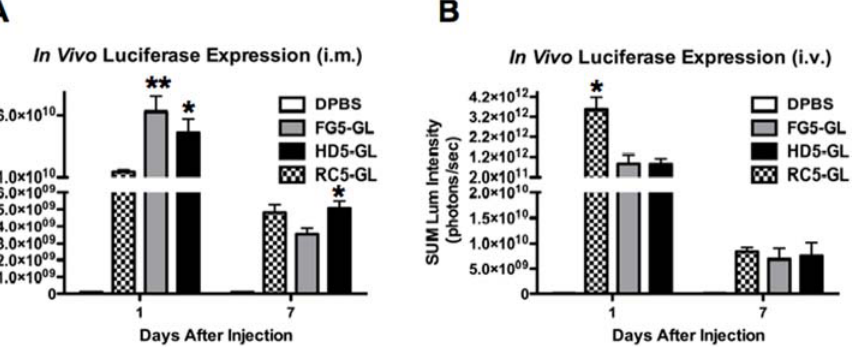
Figure 2. Luciferase imaging. In vivo transduction and expression produced by RC-Ad, FG-Ad, and HD-Ad expressing GFPLuc after i.v. (A) and i.m. (B) immunization. Groups of 5 mice were administered 10 10 vp of the indicated vectors by the indicated routes. The animals were anesthetized, injected with luciferin, and imaged for luciferase activity at 1 and 7 days after injection. Data is shown for sum luciferase intensity for the muscles in i.m.-injected mice and for the liver in i.v.-injected mice. Data is the mean of luciferase activity from 5 mice for each group and error bars indicate standard error. The data were analyzed by one-way ANOVA (*=p , 0.05 and **=p , 0.01).